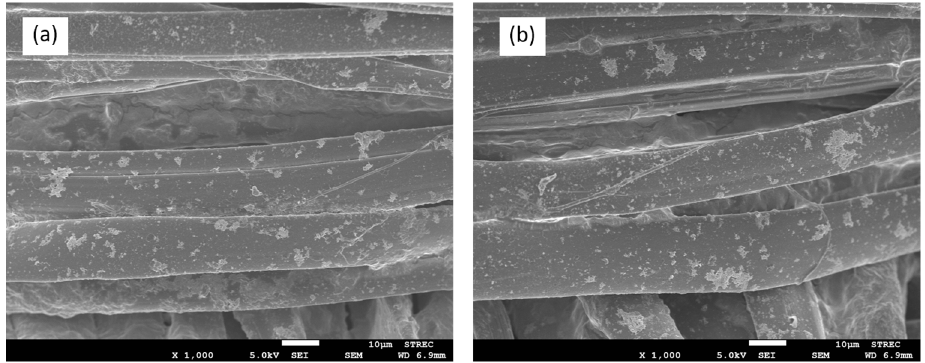
Table 7. Properties of UV protection and antibacterial activity of SS ‐ AgNP samples after washing.